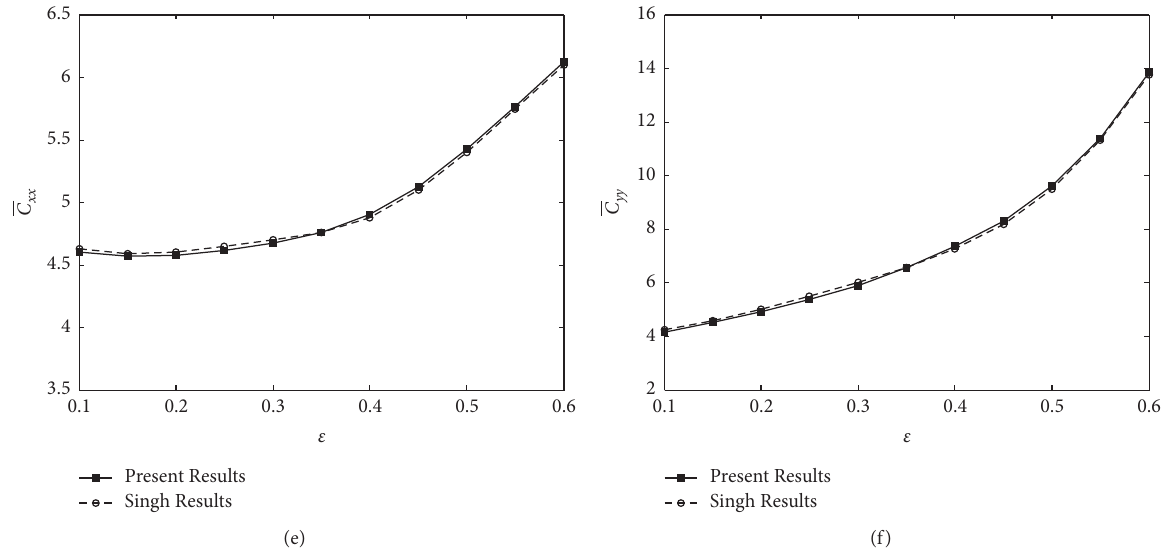
Figure 4: Model validation of static and dynamic performance characteristics of partially textured journal bearing with texture region located at rising pressure region between present results and literature: (a) the load-carrying capacity ( W ); (b) the friction coefficient ( f ); (c) ); (d) the direct stiffness coefficient ( K ); (e) the direct damping coefficient ( C ); (f) the direct damping the direct stiffness coefficient ( K xx yy xx coefficient ( C yy